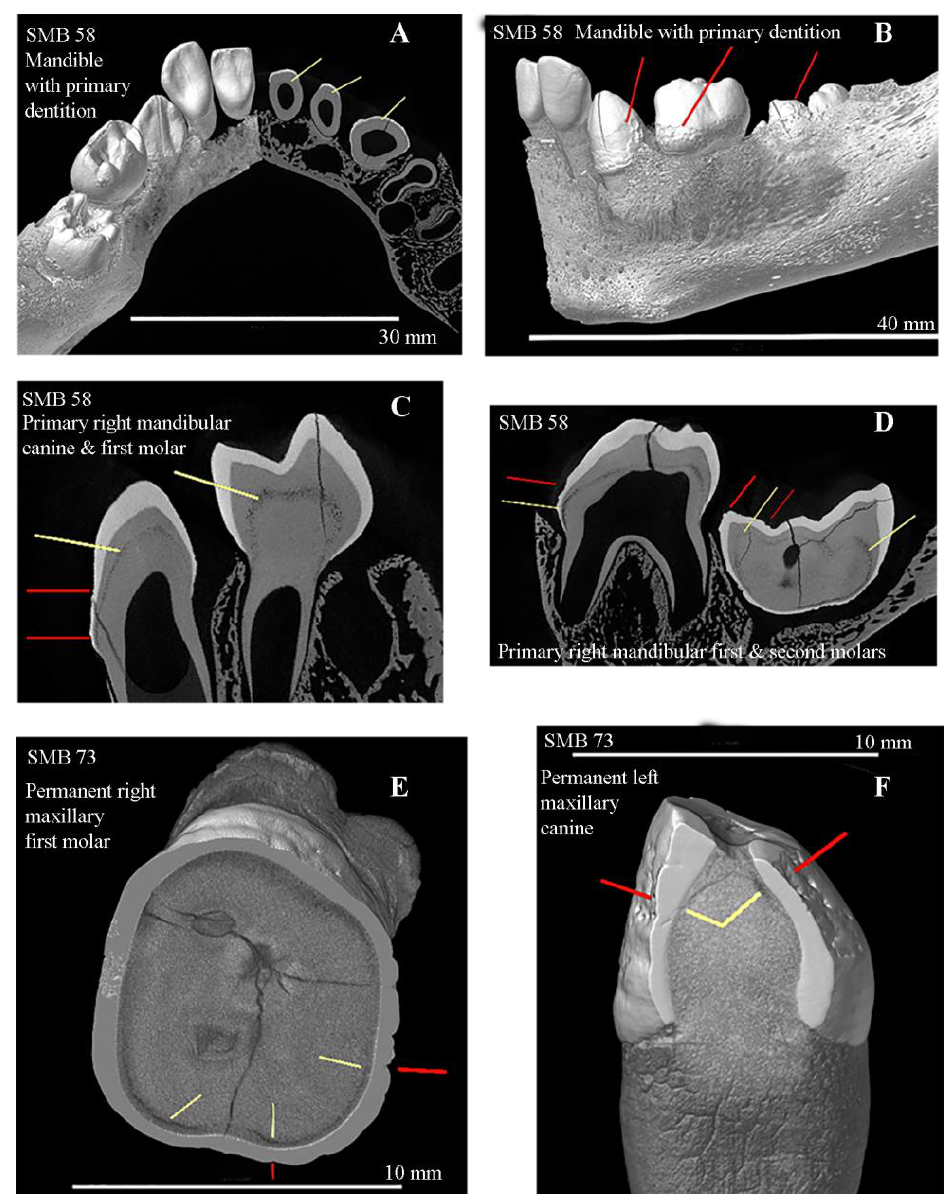
Figure 5. ( A – D ): SMB 58 — infant (dental age range between 1 – 1.5 ± 3 months, skeletal age range between 0 – 2 years of age). Large Volume (LV) Micro-CT scanned at 21 µm/pixel (Table S2). ( A ): Superior/posterior view of the mandible and primary teeth. The left side of the jaw and teeth is shown in 3D and the right side is a 2D LV micro-CT slice of the teeth — yellow lines show interglobular dentine (IGD). ( B ): Lateral view of the mandibular primary dentition — red lines show enamel hypoplastic (EH) defects. ( C , D ): Sagittal slices from LV micro-CT scans of the mandibular dentition (Image C — FDI tooth numbers 83 and 84, Image D — FDI teeth 84 and 85). Yellow lines show areas of IGD in the internal structure of the teeth and the red lines show EH defects on the external structures of the teeth. ( E , F ): SMB 73 — adult male, (skeletal age range: between 30 – 39 years). Individual tooth samples scanned with the Small Volume (SV) Micro-CT system at 9 µm/pixel (Table S3). ( E ): FDI tooth number 16; ( F ): FDI tooth number 23. Both images — yellow lines show areas of IGD and red lines show EH defects in the teeth and at a similar level. All images were created using Avizo software [30] Volren or Orthoslice functions from reconstructed LV and SV Micro-CT scan data. © Angela Gurr.